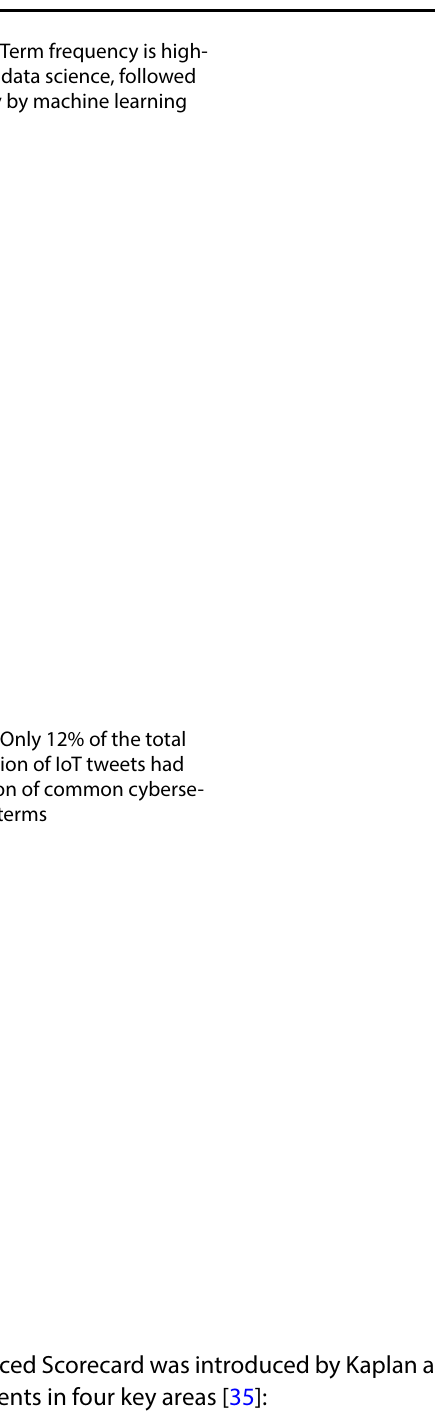
Fig. 5 Term frequency is high- est for data science, followed closely by machine learning